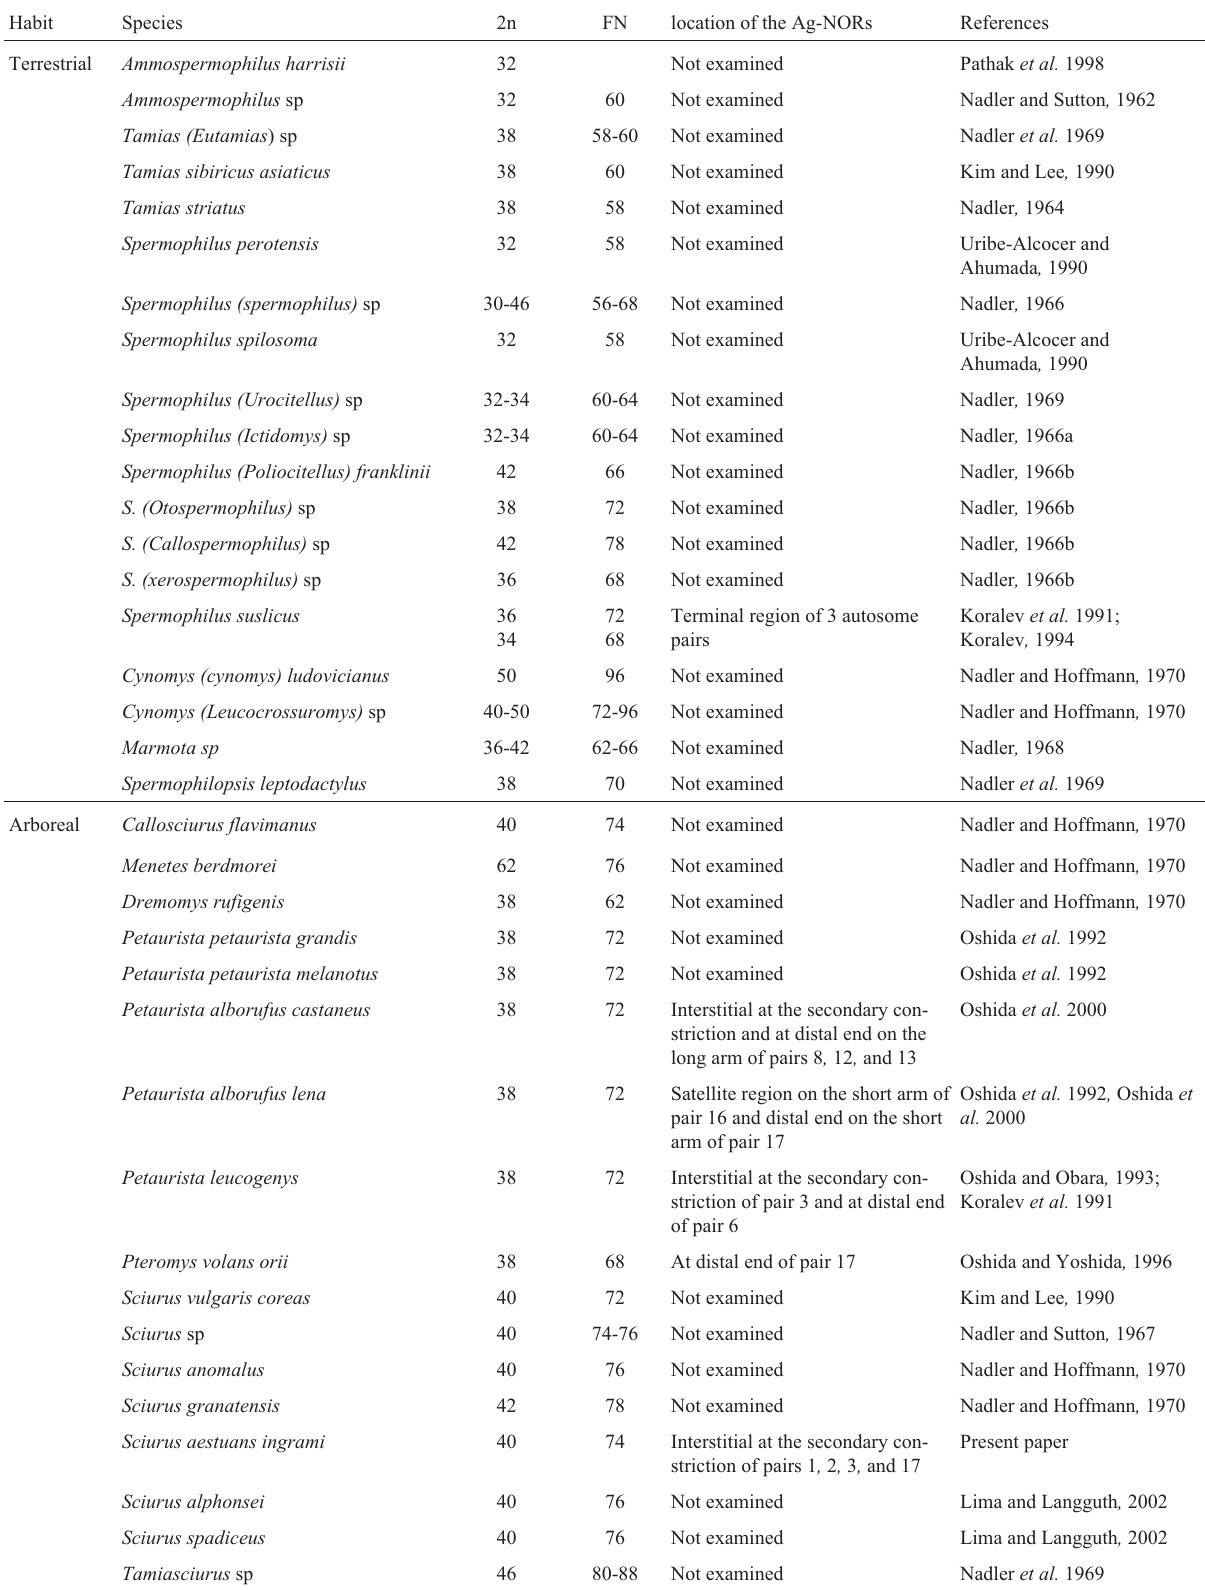
Table 1 - Diploid numbers (2n), fundamental numbers (FN) and location of Ag-NORs of terrestrial and arboreal representatives of the subfamily Sciurinae.